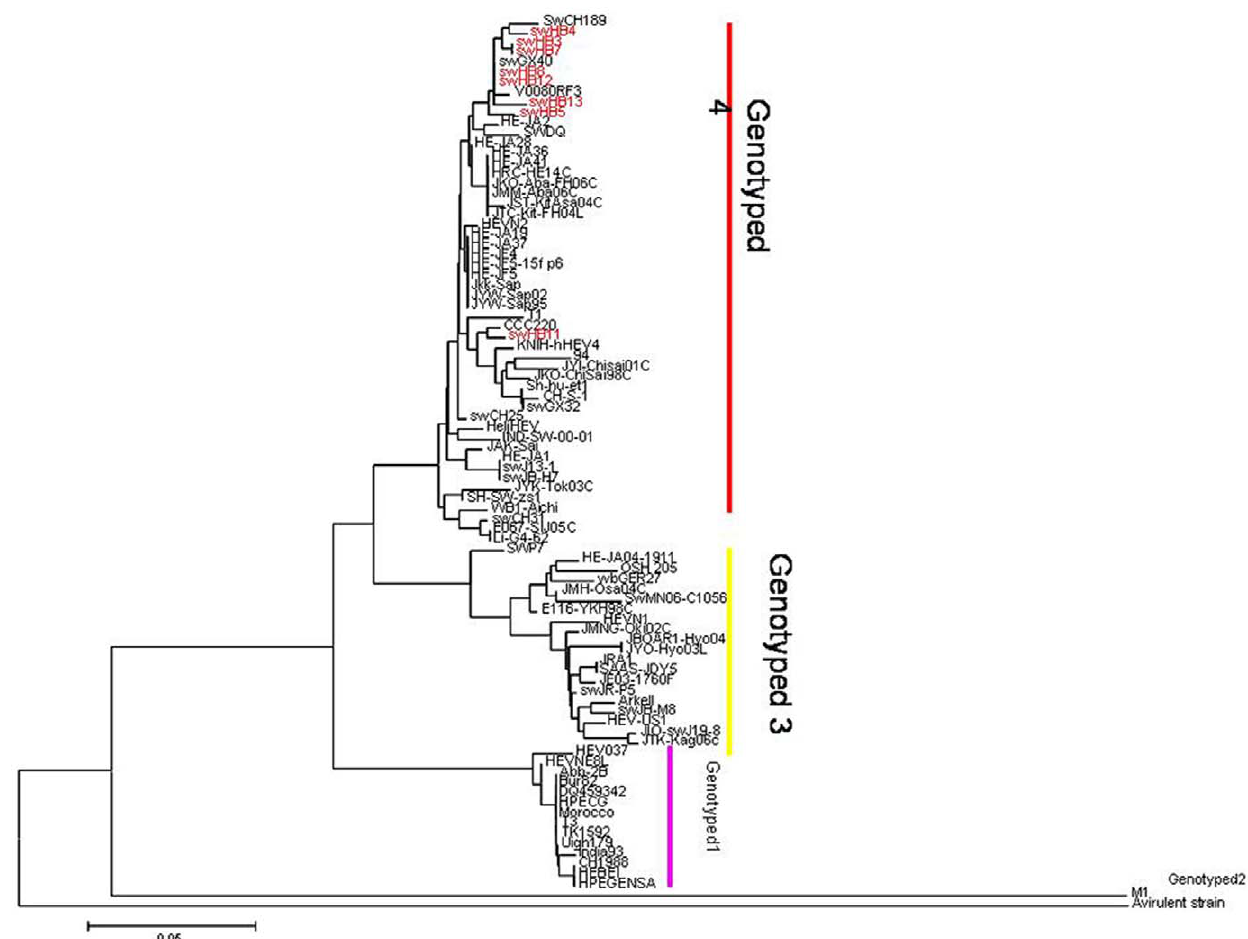
Figure 3. Phylogenetic tree of ORF2/ORF3 of HEV isolated from swine fed on kitchen residue. Swine HEV isolated as part of this study are shown in capitals and are labeled SWHB-3–5, 7, 8 and 11–13. The scale bar represents an evolutionary distance of 0.05 nucleotides per position.